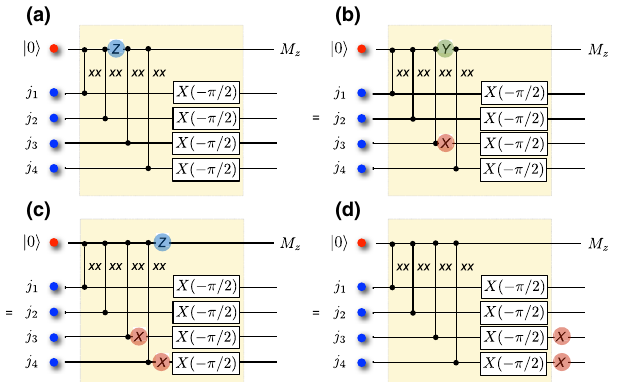
FIG. 7. Non-fault tolerance of single-ancilla MS-based stabi- lizer readout: Illustration of an error event, in which a single phase-flip error Z on the ancilla qubit occurs between the second and the third MS gates (a). This error propagates into the data qubit layer (b) after the third MS gate, where it results in two bit single-qubit flip errors on the data qubits (c). These two errors correspond ultimately to a logical bit-flip error (d) that cannot be corrected by the